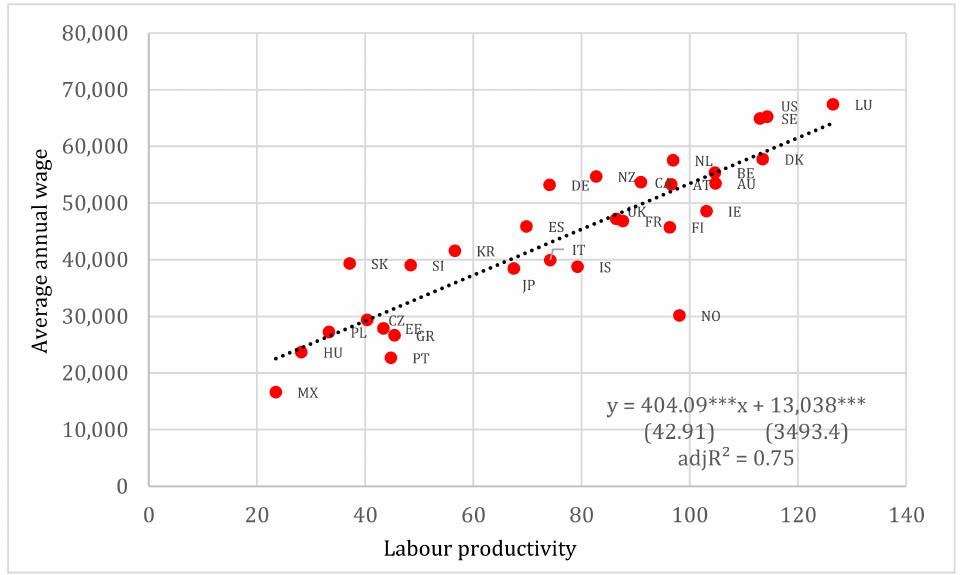
Figure 5. Labour productivity vs. average annual wages (in USD pps). Note: Standard errors reported in parentheses. *** denotes 1% level of statistical significance.